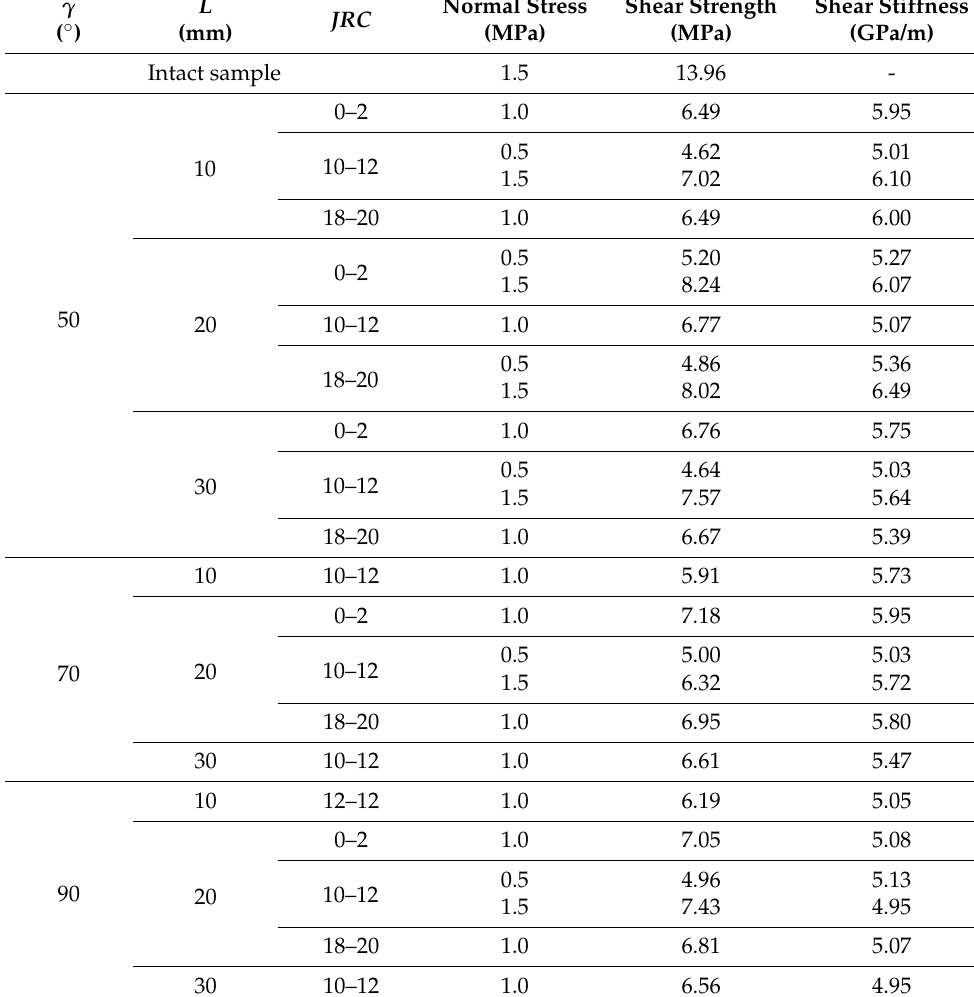
Table 6. Numerical Simulation results and their corresponding